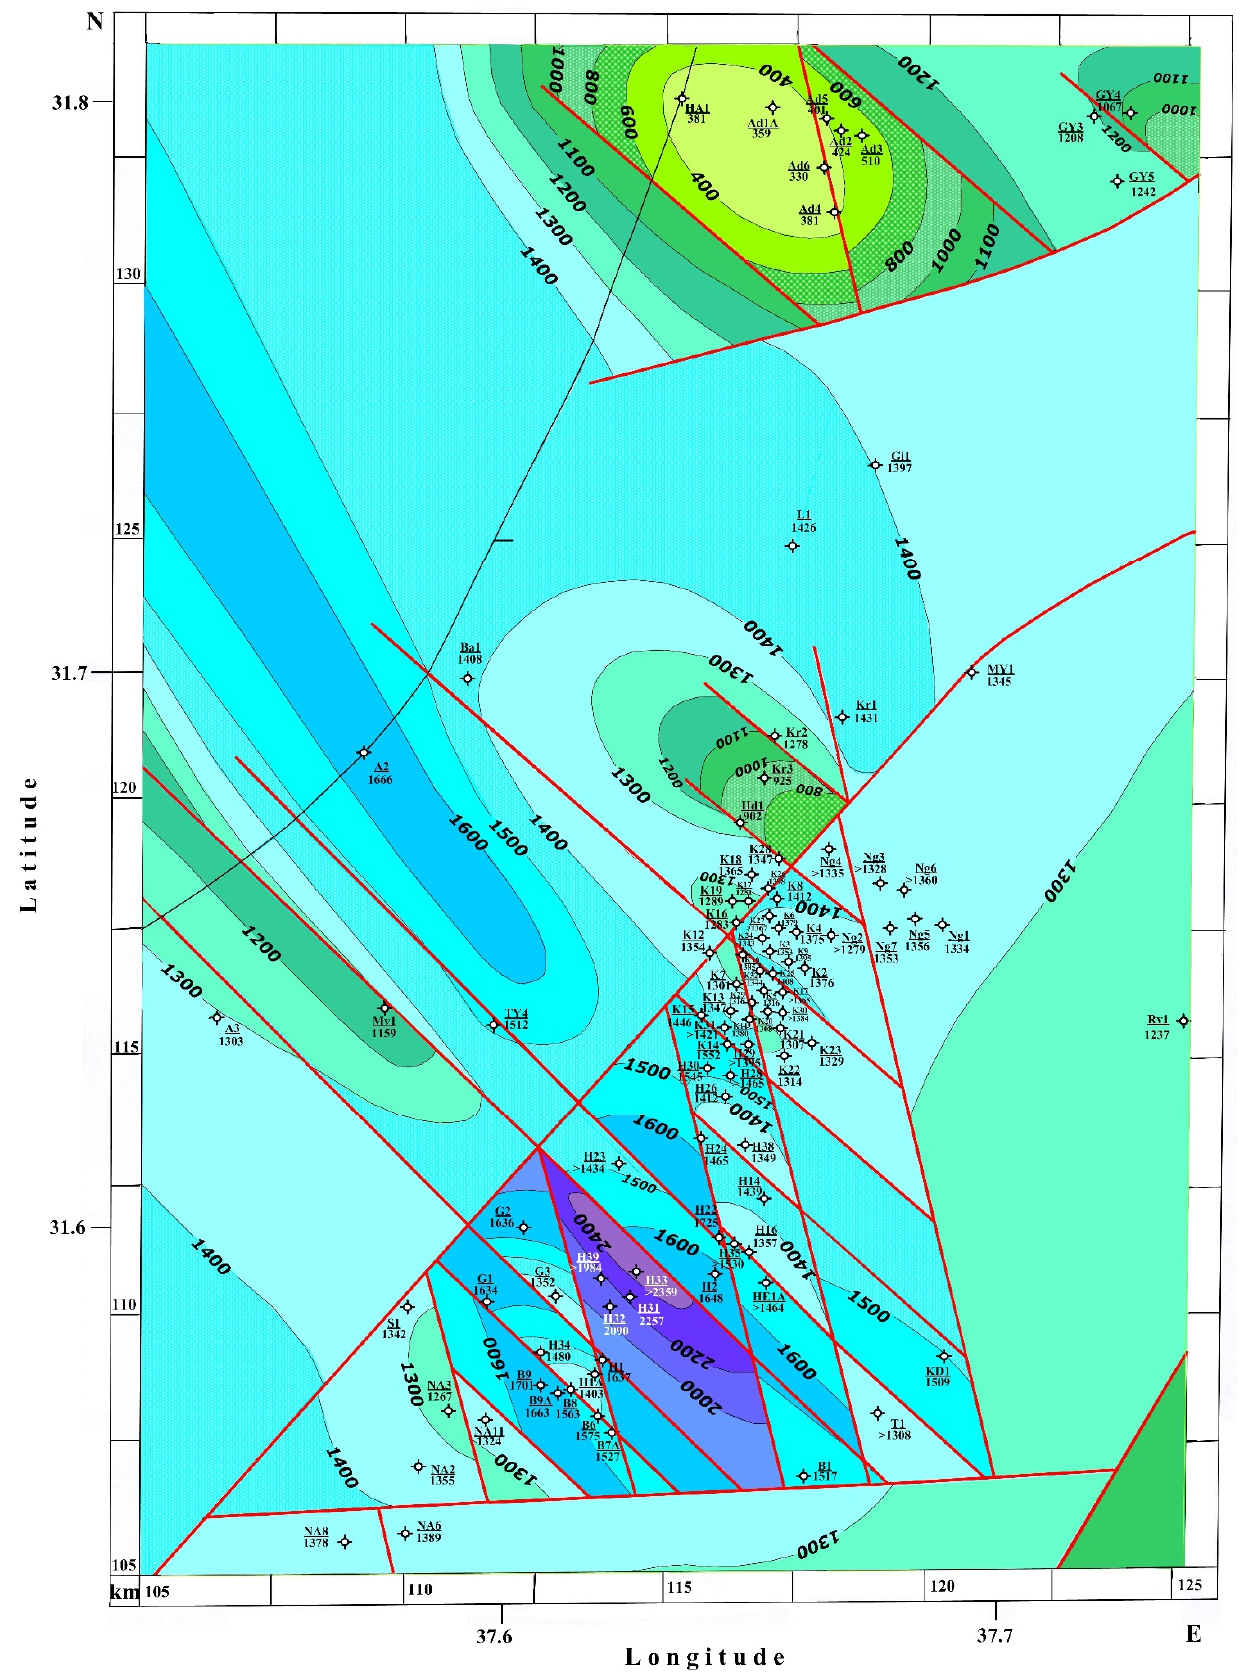
Figure 6. Early Cretaceous structural–paleogeographic map of the Heletz oil field. Borehole abbreviations: see captions for Figure 2.